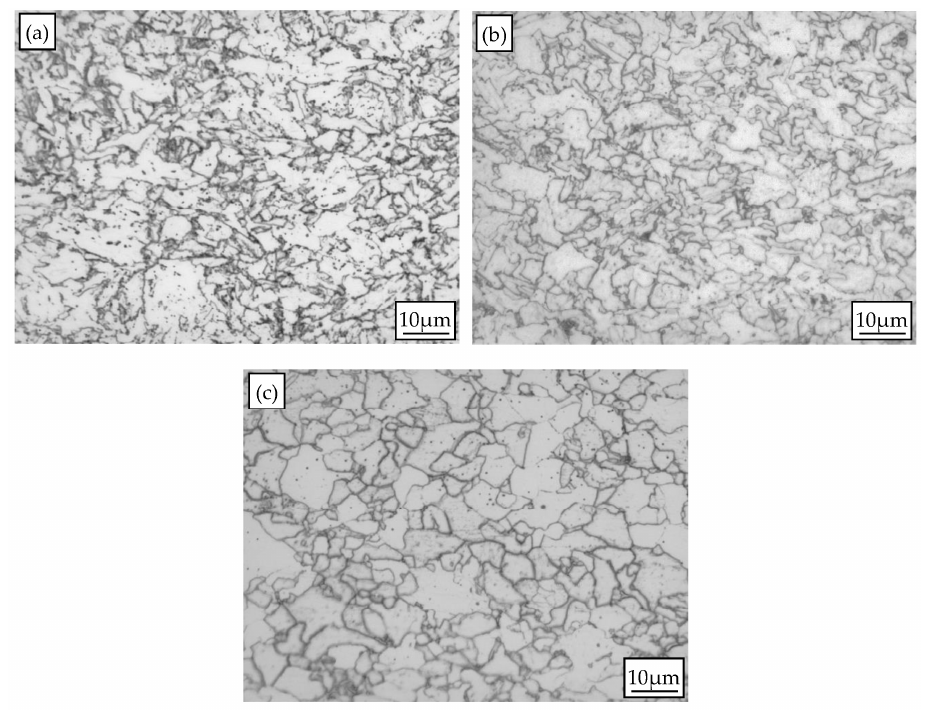
Figure 2. OM micrographs of experimental steel coiled at different temperatures: ( a ) 600 °C; ( b ) 650 °C; ( c ) 700 °C.